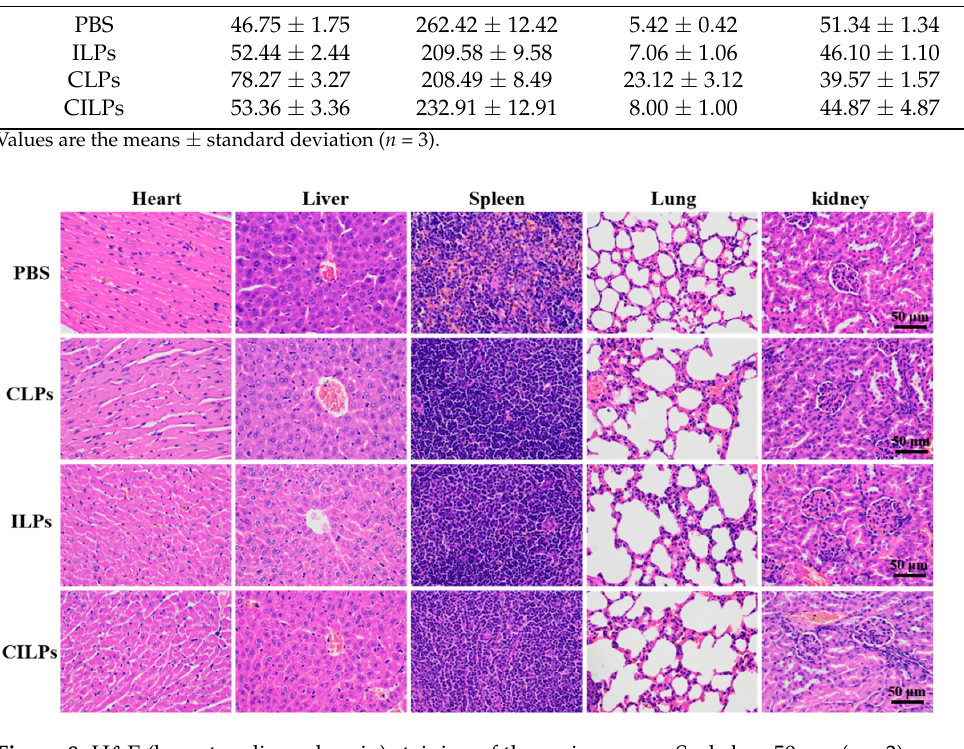
Figure 8. H&E ( hematoxylin and eosin) staining of the main organs. Scale bar, 50 µm ( n = 3). Table 3. The biochemical parameters of the liver and